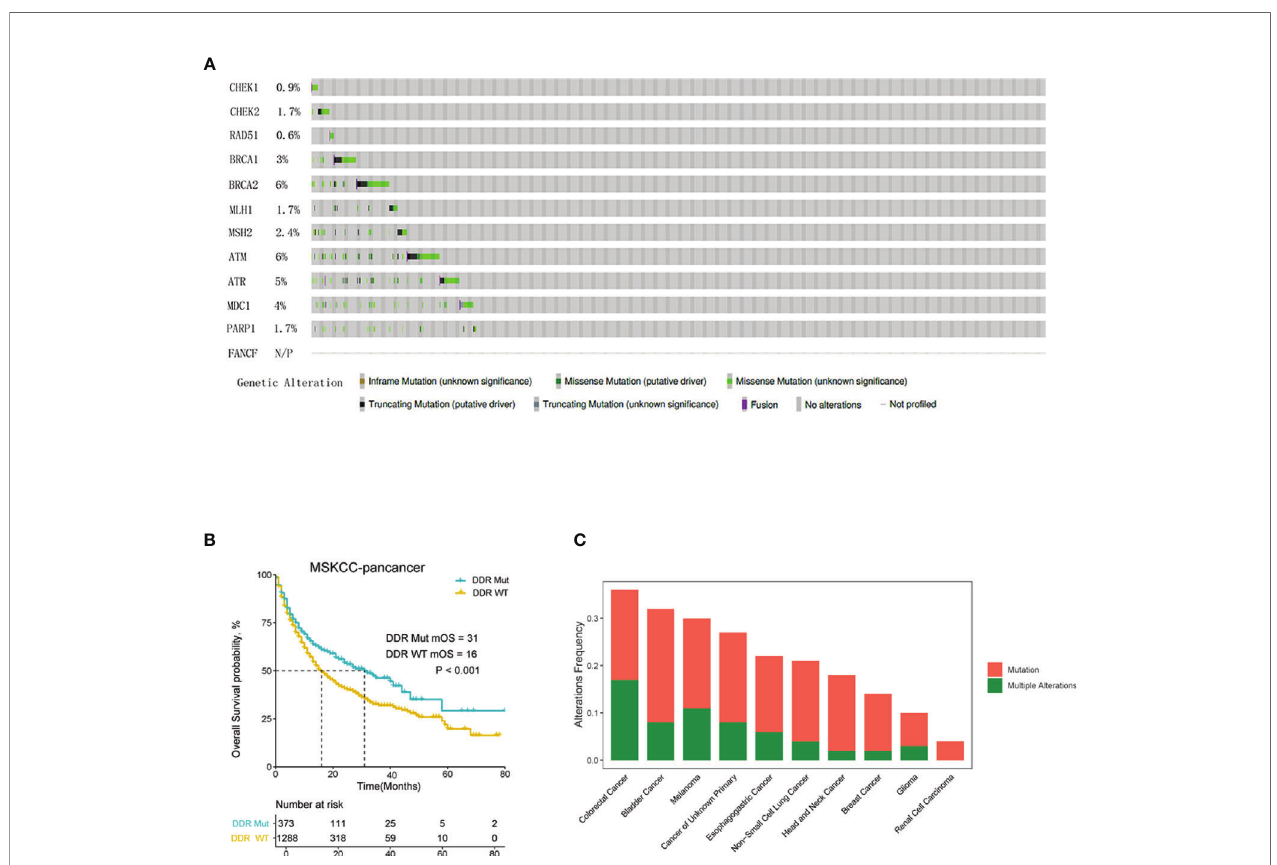
FIGURE 1 | DNA damage repair (DDR) mutation is a pan-cancer prognostic biomarker for cancer patients with immune checkpoint inhibitor (ICI) immunotherapy. (A) The mutation frequency of 12 DDR genes in MSK-IMPACT clinical sequencing cohort was derived from cBioPortal. (B) Overall survival Kaplan-Meier curves of the DDR Mut and WT groups. (C) Frequency of DDR mutation in patients with different cancer